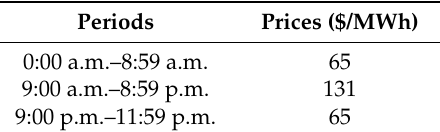
Table 3. Time-of-use pricing.